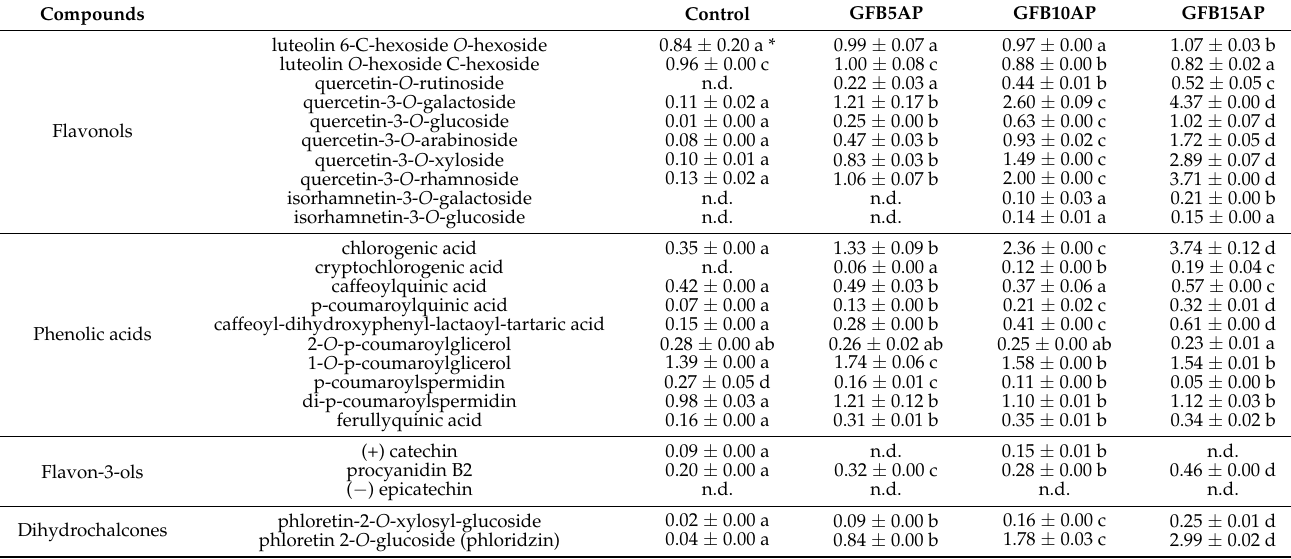
* Presented data are mean values ± standard deviation (values signed the same letters a–d in particular lines are not significant at 0.05 level of confidence). n.d.—not